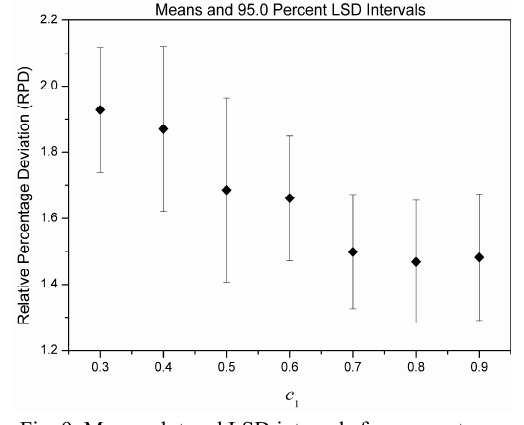
Fig. 9. Means plot and LSD intervals for parameter c 1